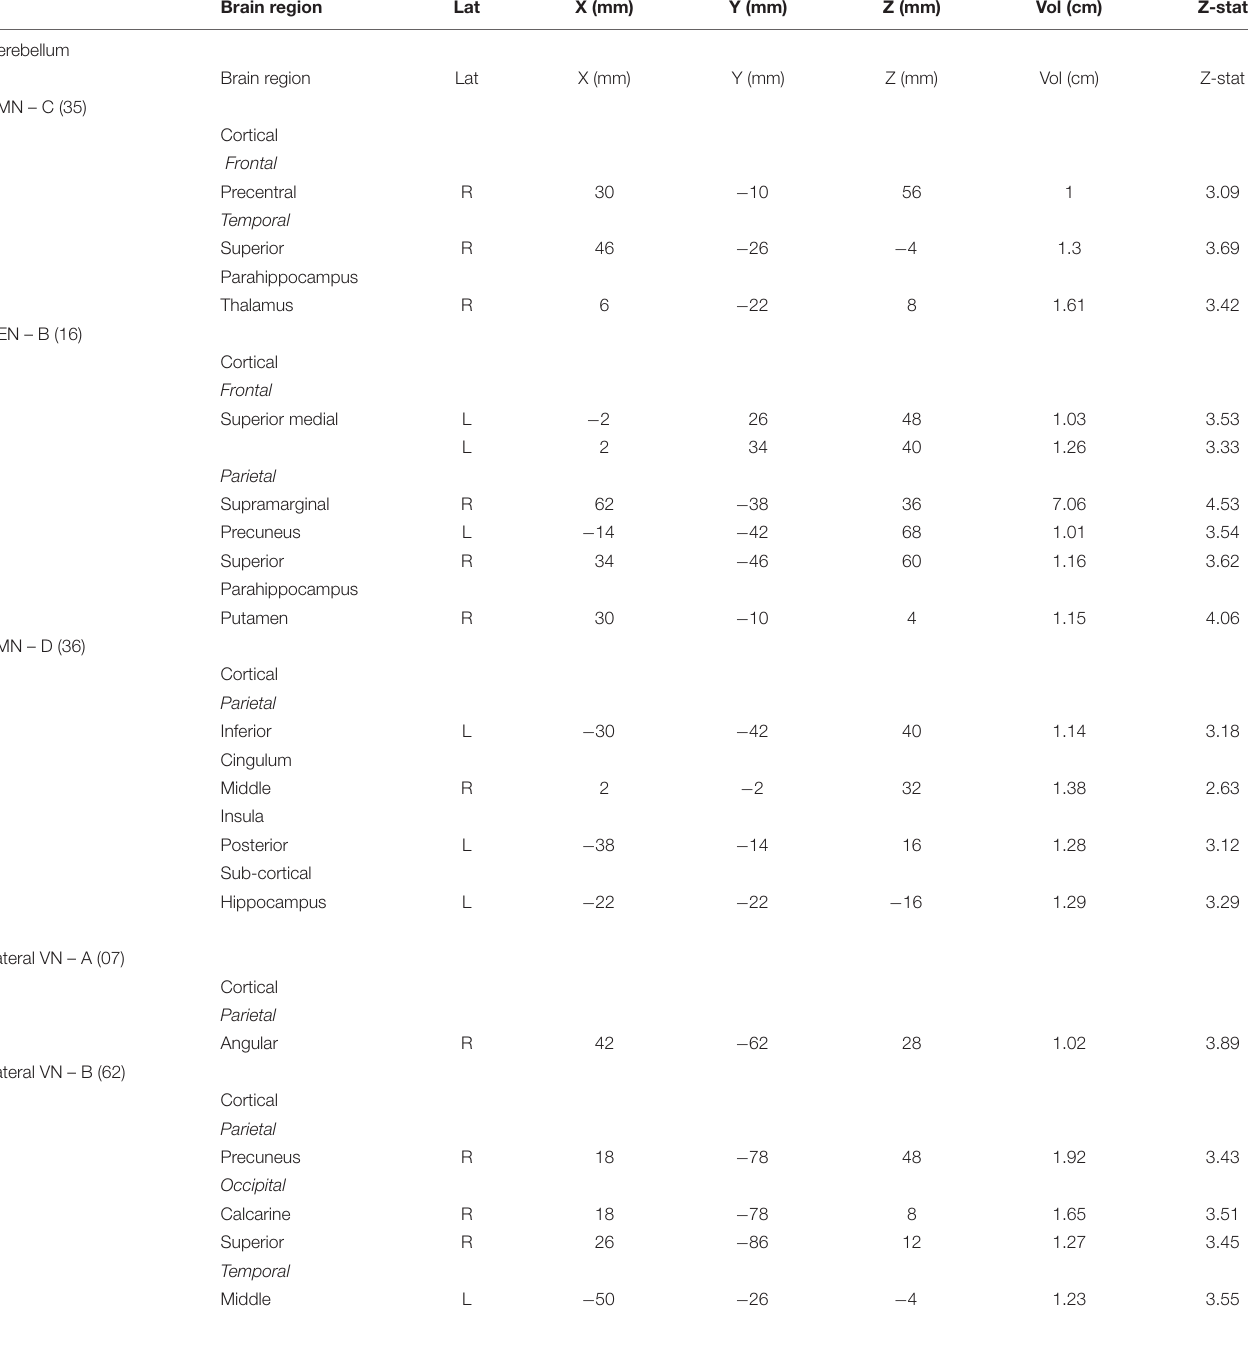
The table indicates brain areas of significant increased connectivity with the listed networks for young adults with migraine vs. adolescents with migraine and healthy controls. Coordinates and max statistical value (z-stat) are given for peak activity as well as volume (Vol) of each cluster of activity. “Lat” indicates the brain laterality (i.e., R, right side, L, left